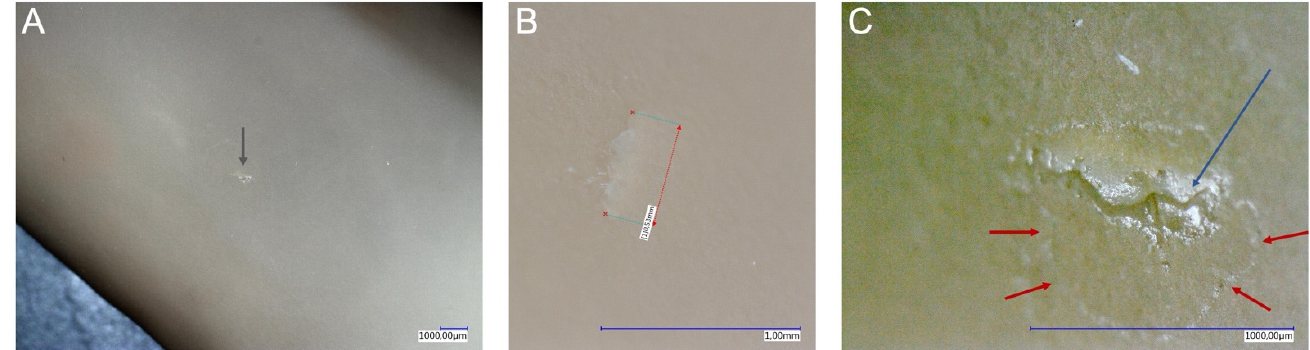
Figure 2. A typical microlesion of the glove as it occurs during endoscopic procedures (TAPP) under the digital microscope. ( A ) A microlesion with 20× magnification (grey arrow). ( B ) The lesion at 150× magnification and corresponding measurement of size. ( C ) The lesion at 200× depth magnification; the blue arrow marks the actual crack, and the red arrows mark the water leakage area as evidence of the pervasiveness of the lesion.